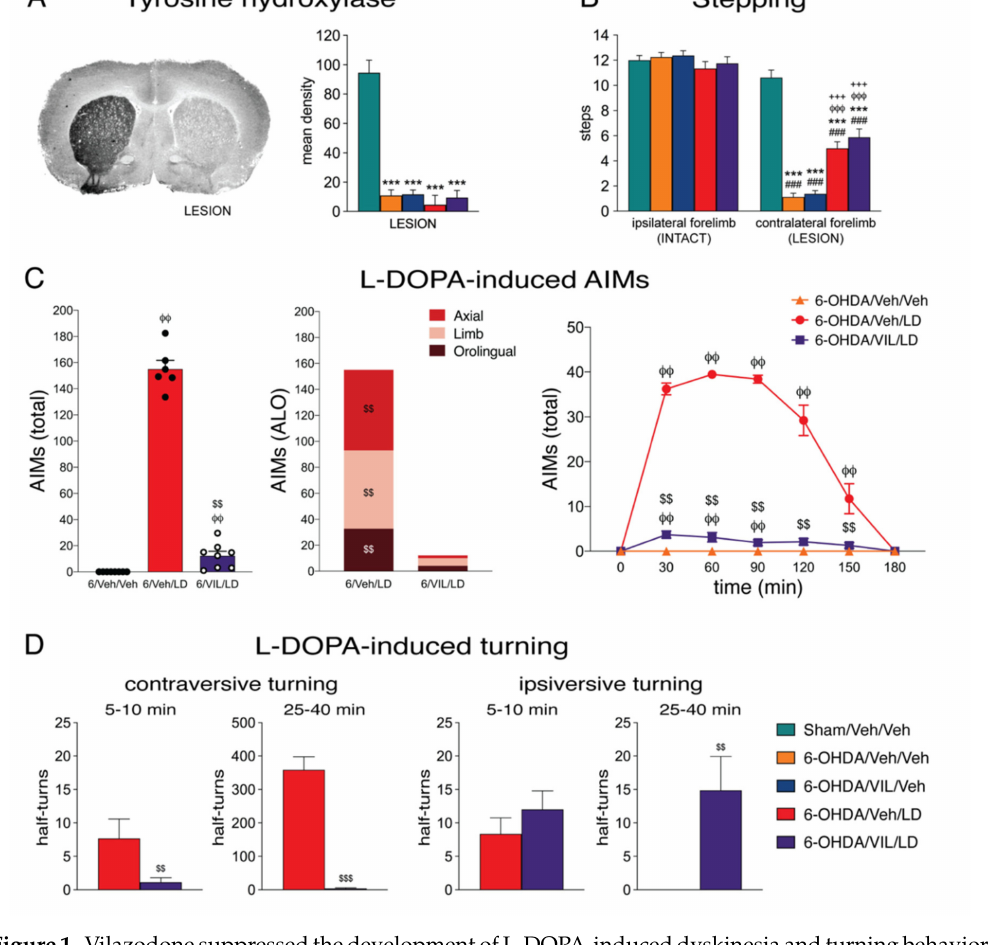
Figure 1. Vilazodone suppressed the development of L-DOPA-induced dyskinesia and turning behavior, but not stepping improvement, after dopamine depletion by 6-OHDA. ( A ) Dopamine depletion (i.e.,